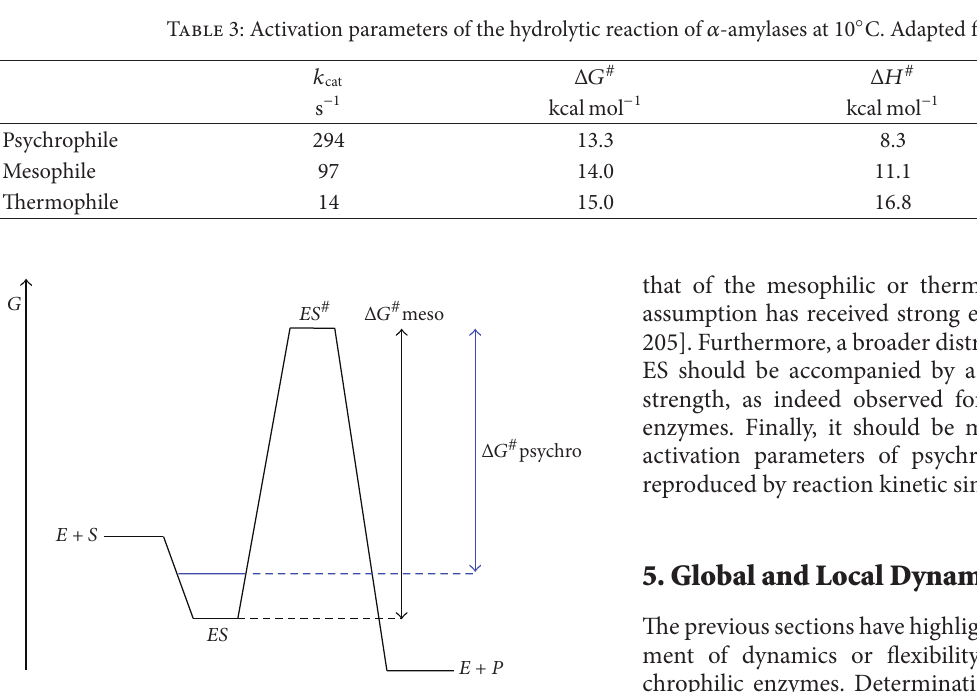
F 7: Optimization of activity by decreasing substrate affinity in psychrophilic enzymes. �eaction pro�le for an enzyme-catalyzed reaction with Gibbs energy changes under saturating substrate concentration. Weak substrate binding (in blue) decreases the psychro ) and thereby increases the reaction activation energy ( rate. Adapted from # Δ𝐺𝐺